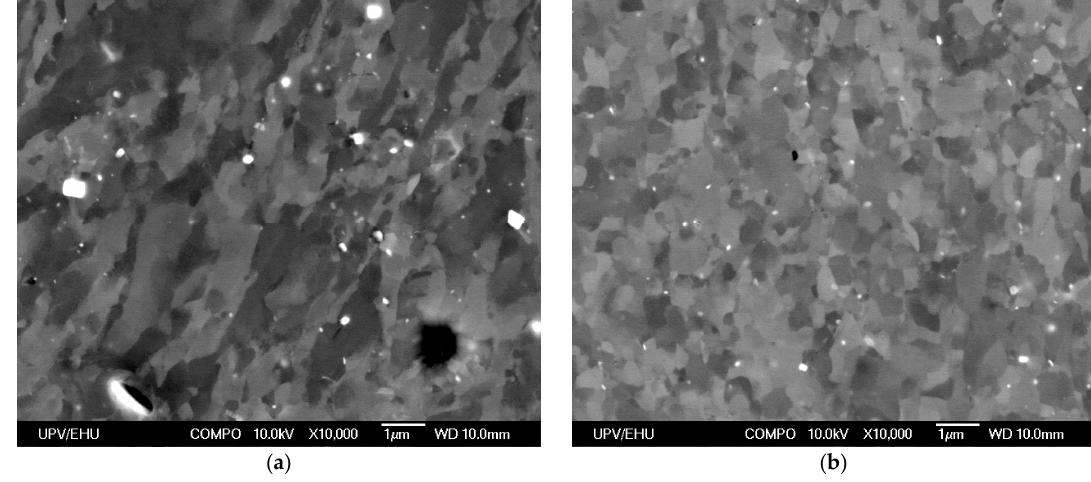
Figure 5. SEM micrographs of different isothermally ‐ forged AA ‐ 5754 states: ( a ) AA ‐ 5754 at N0 (annealed); ( b ) AA ‐ 5754 at N2 (ECAP ‐ processed). Taken from the research work by León et al. [23].